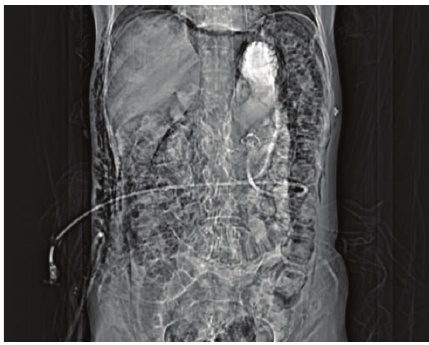
Figure 2: Abdominal X ray with contrast given from the PEG catheter. There was no intra-abdominal leakage.